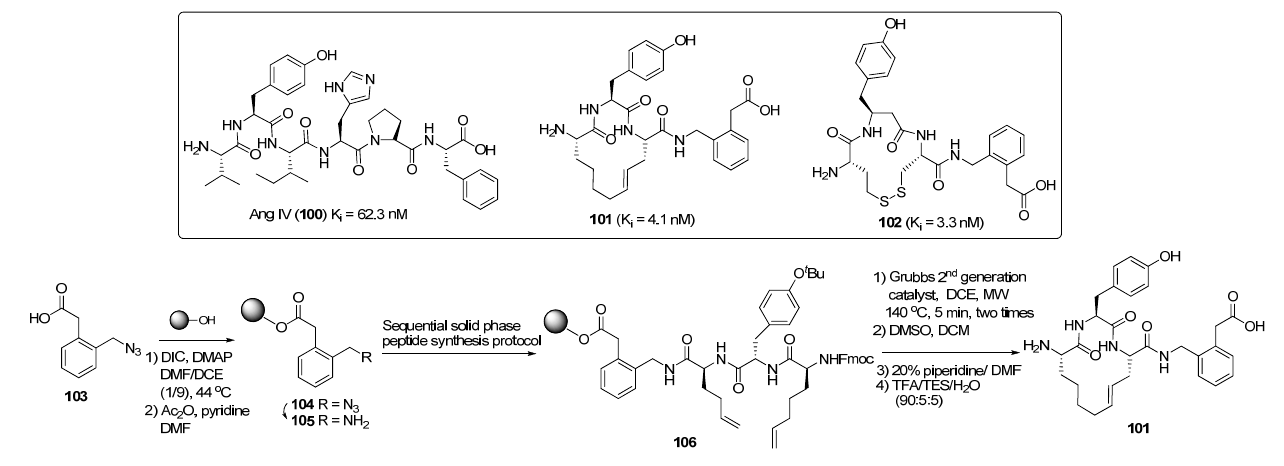
Scheme 26. Solid phase supported synthesis of angiotensin IV analogue 101